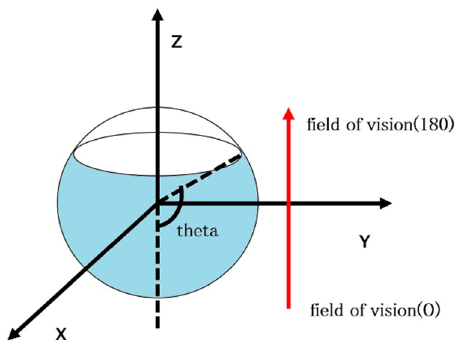
Figure 15. Achieving limited view from full-view images by decreasing theta.